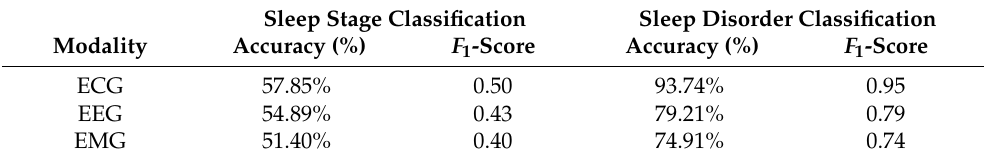
Table 4. Experiment 1: Classification results for the baseline single-modality CNN